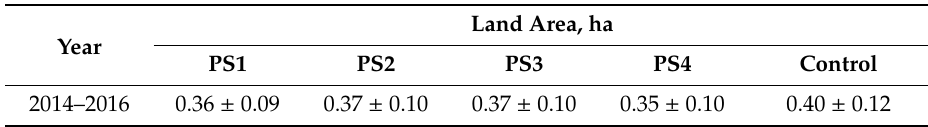
Figure 6. Average percentage of the farm machinery operations (with materials: seeds, fertilizers, pesticides, sealants etc.) on total energy consumption (MJ t − 1 ) in 2014, 2015, and 2016. Depending on the loss and yield of WOSR occurred each year; a di ff erent area (ha) is needed to produce 1 t of WOSR seeds. In this study 0.35 ± 0.10 ha of area was needed to produce 1 t of WOSR seeds by applying PS4 as shown in Table 5. Table 5. Effect of pod sealant on area (ha) needed to produce 1 t of winter oilseed rape (WOSR) seeds in 2014 – 2016.